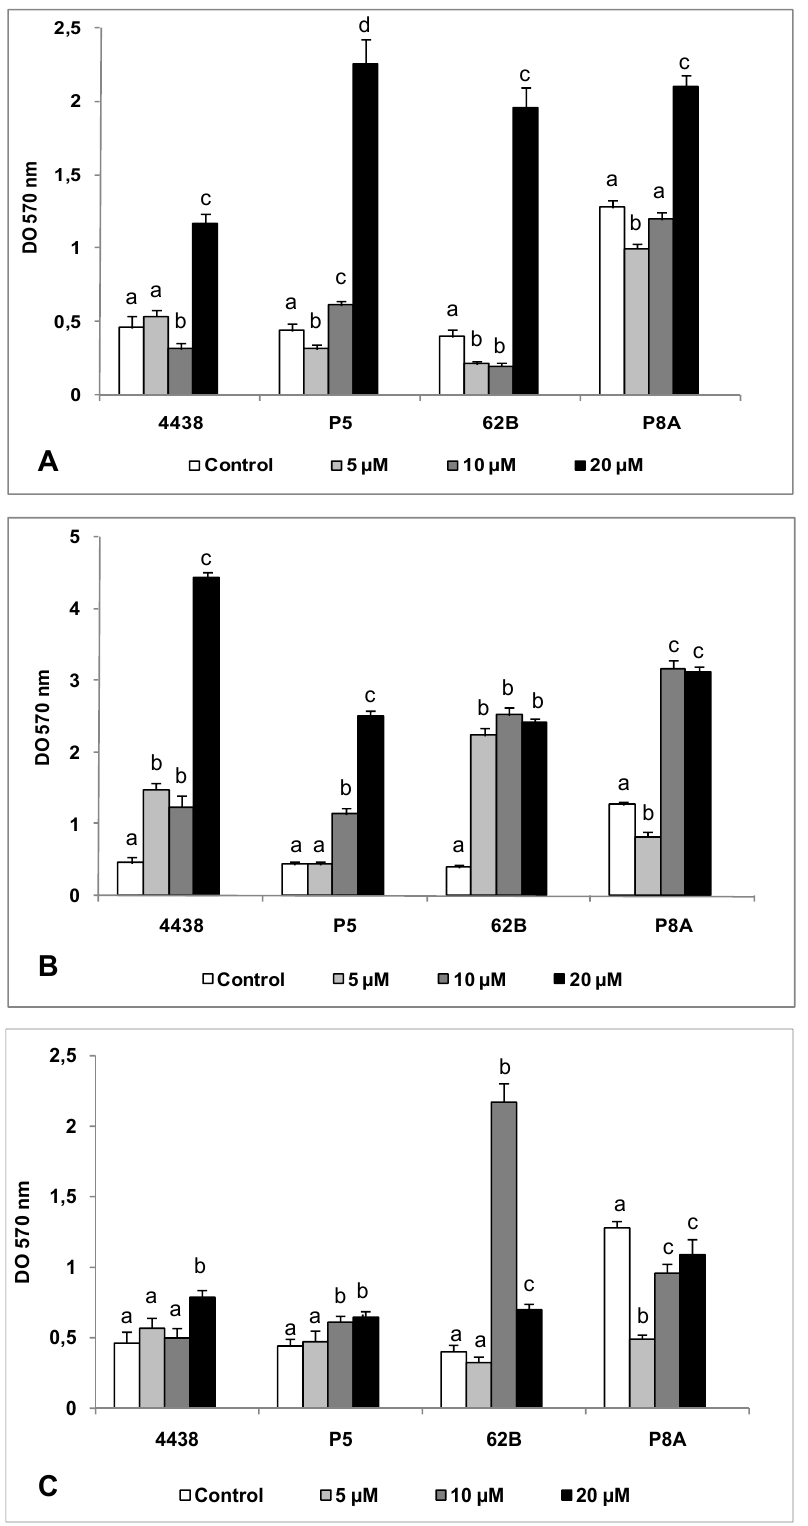
Figure 4. Effect of AHLs on biofilm formation ability of peanut-nodulating